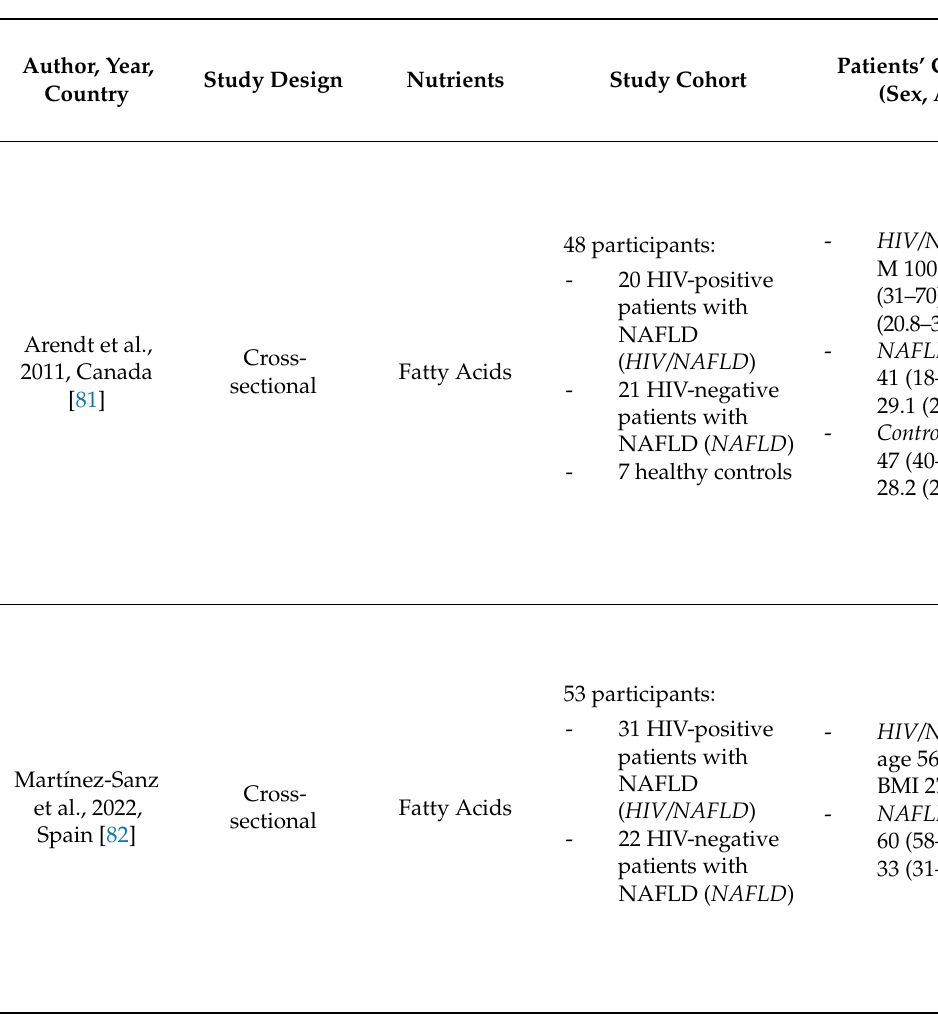
Table 1. Studies evaluating the role of macronutrients in hepatic steatosis and/or liver fibrosis in people with